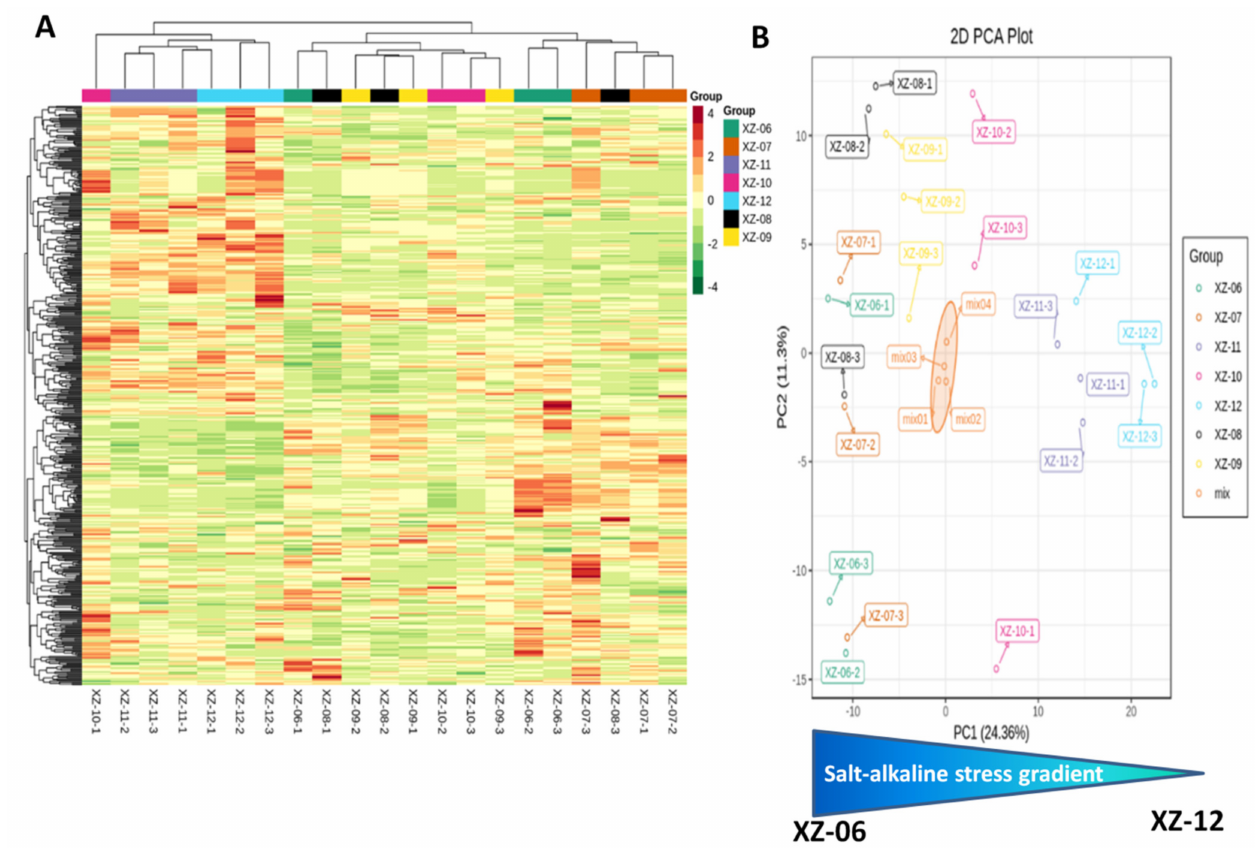
Figure 3. Profiles of metabolites in ripe fruits of wolfberry from 6 stress gradients. ( A ) Hierarchical clustering heatmap of metabolites based on ion intensity; and ( B ) principal component analysis (PCA). Six salt-alkaline gradients were collected, numbered sequentially from XZ-06 to XZ-12. Mix represents the mixed samples used for quality control. Log2 fold change of the metabolite ion intensity were used in the analyses. The salt-alkaline stress gradients were schematized below the PCA from the highest (XZ-06) to the lowest